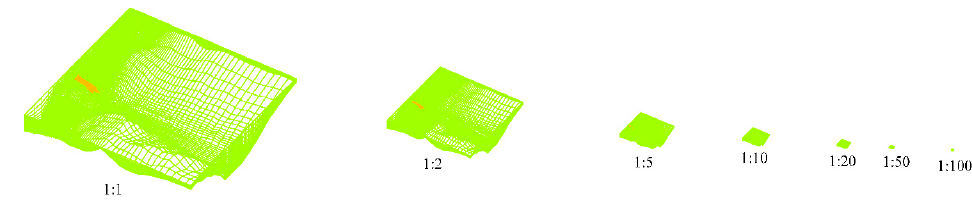
Figure 4. Calculation grids of different geometric scales.